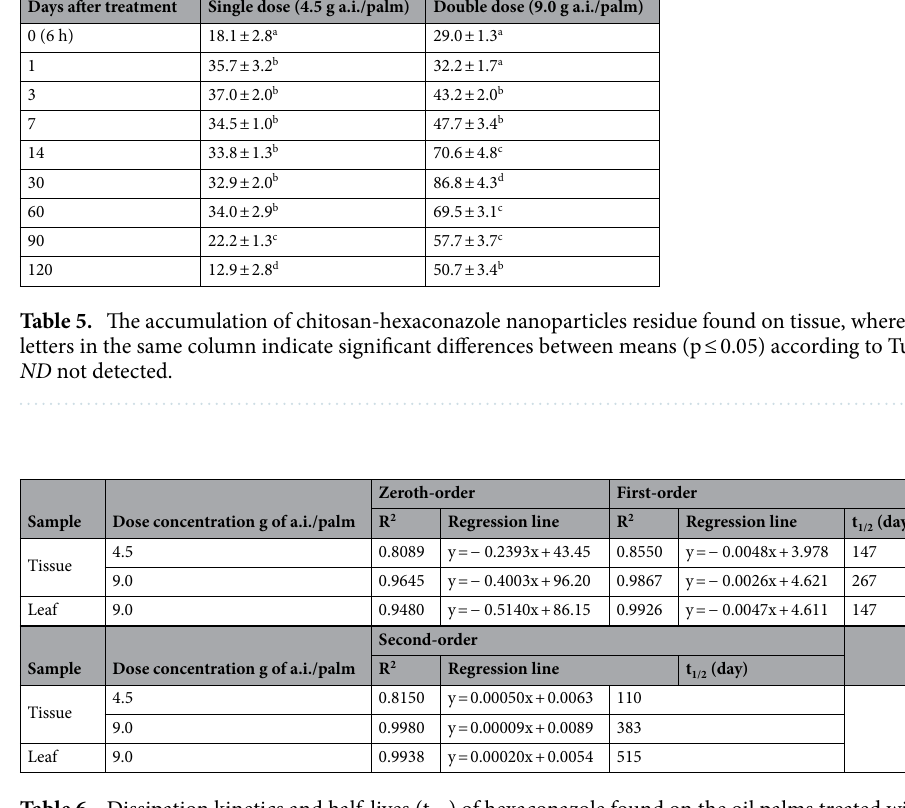
Table 6. Dissipation kinetics and half-lives (t 1/2 ) of hexaconazole found on the oil palms treated with the agronanofungicides at different a.i. concentrations.